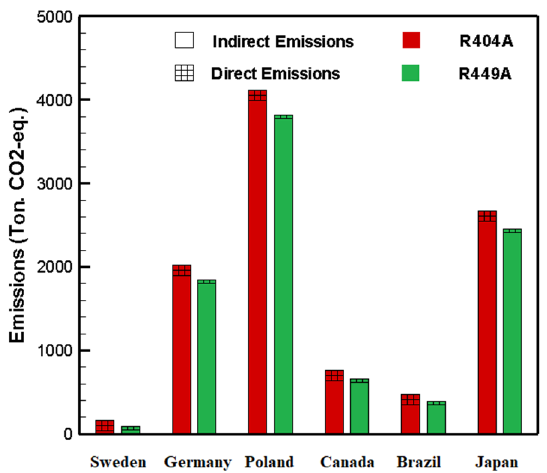
Figure 13. Equivalent CO 2 emissions of the MT system (emission factor (kgCO 2 .eq kWh − 1 ) used in this study from ref. [26] Sweden: 0.012; Brazil: 0.074; Canada: 0.0130; Germany: 0.378; Japan: 0.506; Poland: 0.791).